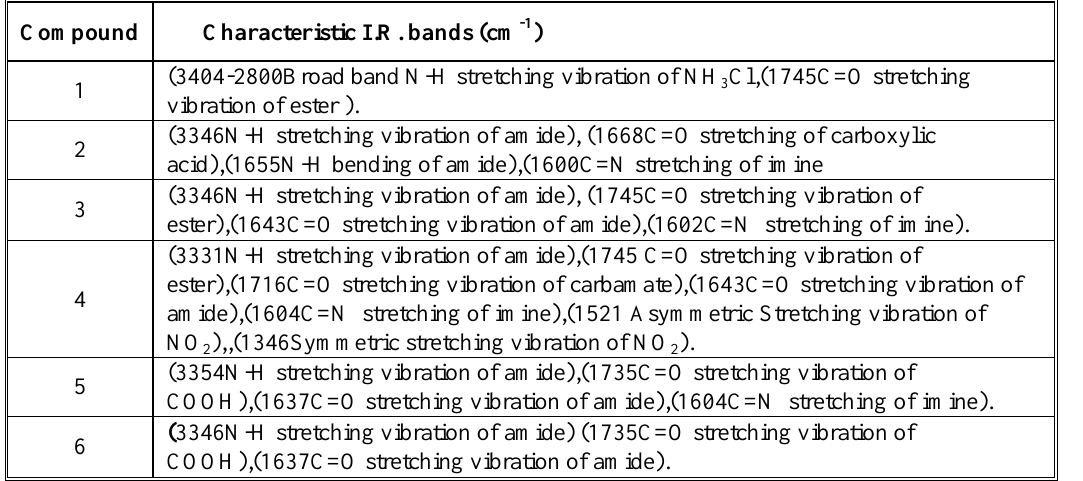
Table (3): The characteristic IR bands of synthesized